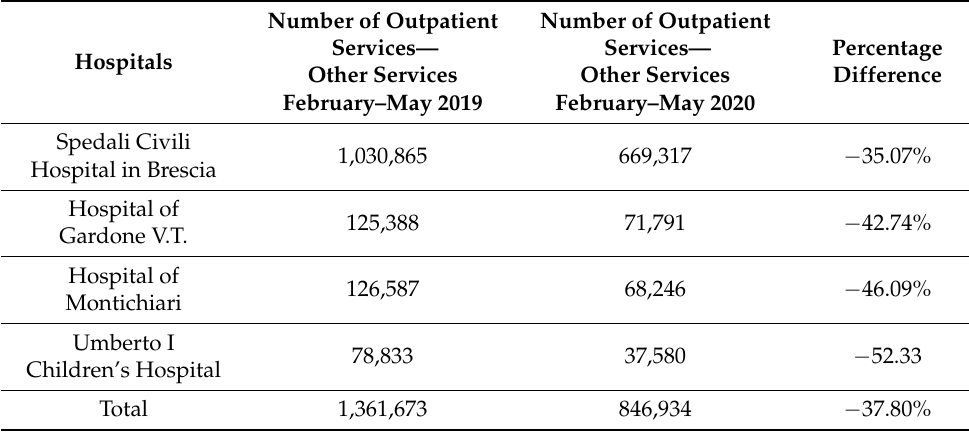
Table 7. Outpatient performance reduction